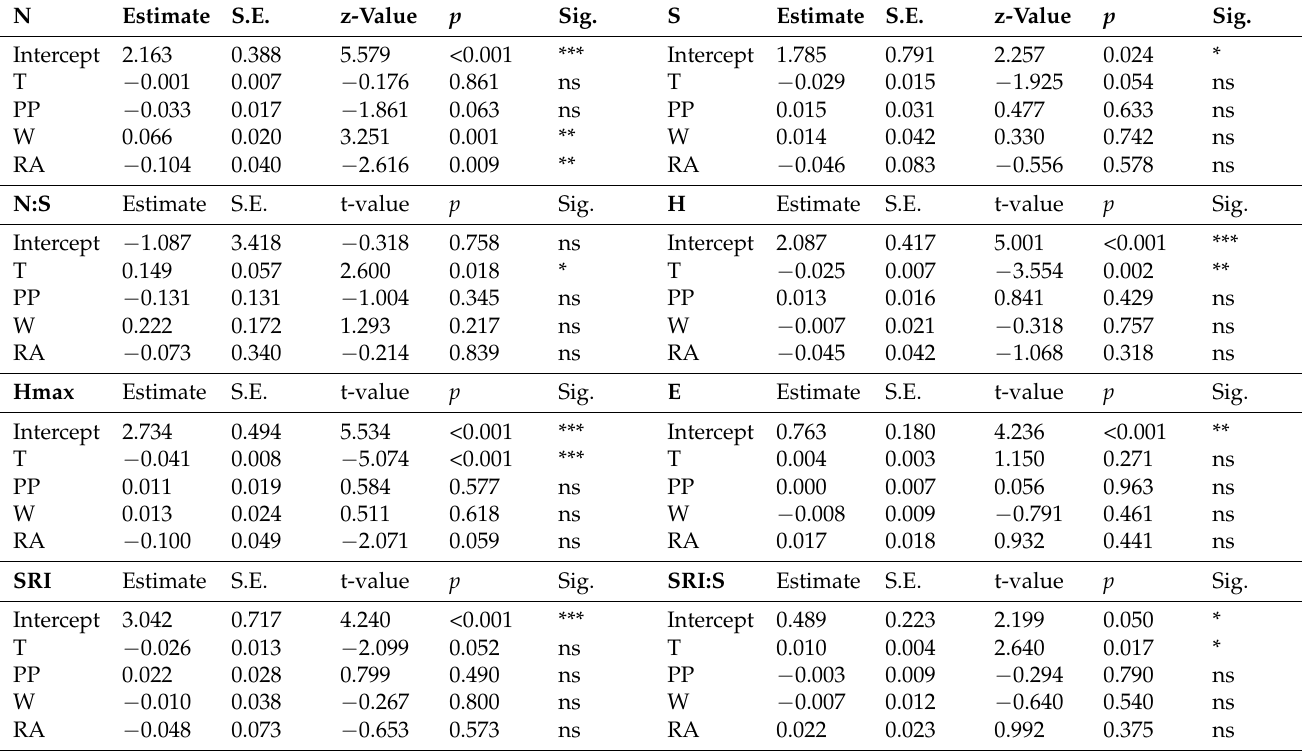
Table 3. GLMM testing effects of climate on variations of biodiversity parameters in scorpions of the Algerian